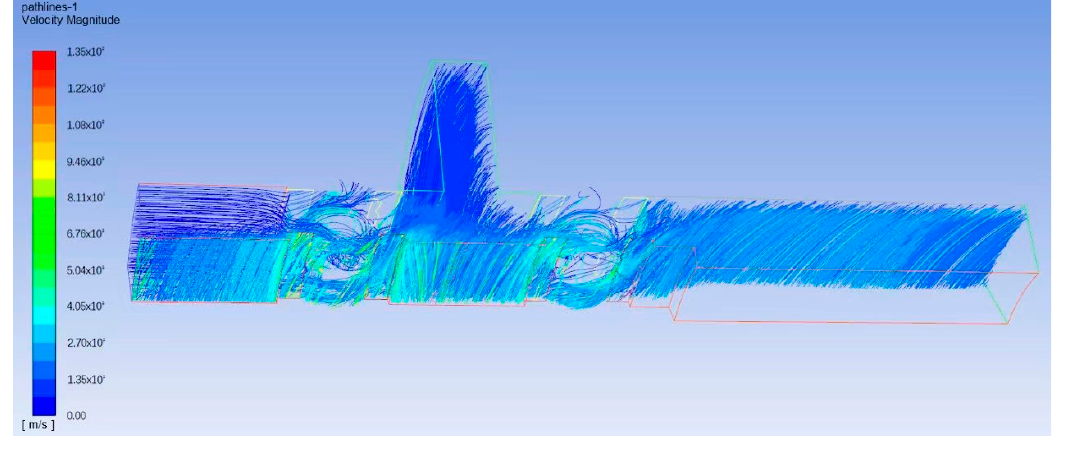
Figure 24. Temperature distribution. Figure 23. LN2 flow lines.